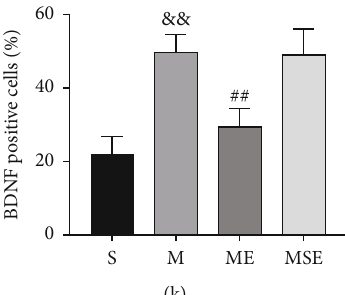
Figure 2: EA upregulated the expression of miR-206-3p and inhibited the expression of the target gene BDNF, while decreasing the expression of BAX/Bcl-2, IL-6, and TNF- α after CCI. (a, b) The expression of miR-206-3p and BDNF mRNA ( n = 5 ). (c, d) Representative western blots and quanti fi cation data of BDNF/GAPDH ( n = 5 ). (e – i) Representative western blots and quanti fi cation data of BAX/Bcl-2, IL-6/GAPDH, and TNF- α /GAPDH ( n = 5 ). (j, k) Staining for BDNF-positive (red) cells from the spinal dorsal horn (scale bars: 100 μ m 100x; 20 μ m, 400x) ( n = 5 ). Bars indicate the mean ± SD . && p < 0 : 01 versus the S group; ## p < 0 : 01 versus the M